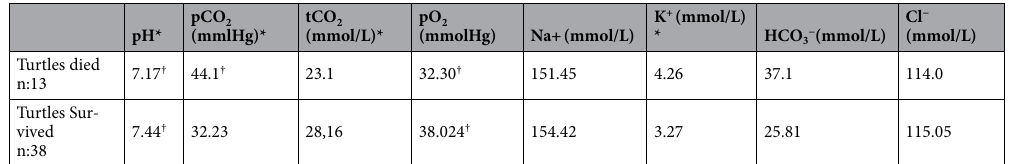
Table 3. Mean of the blood gas results in dead and surviving GE-affected turtles. *p < 0.05. † Value out of range 23 .